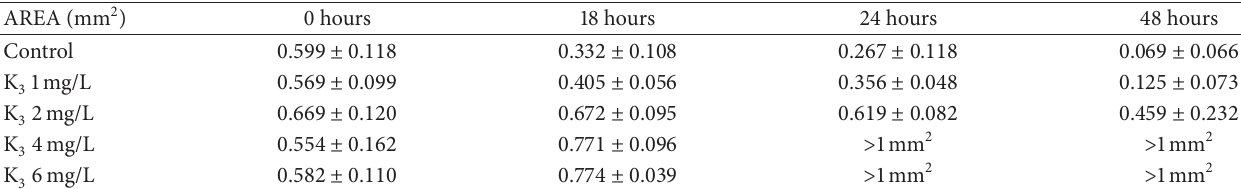
Table 1: Measurement of the wound areas (values are expressed as mean ± SD).